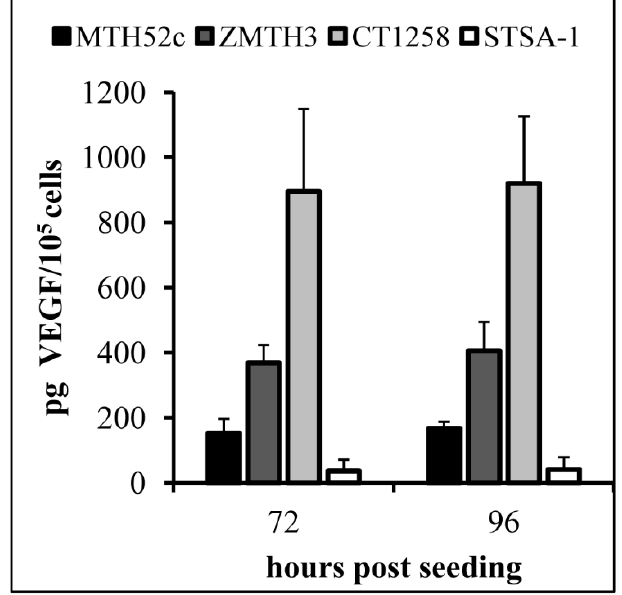
Figure 1. VEGF expression in MTH52c, ZMTH3, CT1258 or STSA-1 canine cancer cells under cell culture conditions. Each value represents the mean ( n = 3) +/ − standard deviations